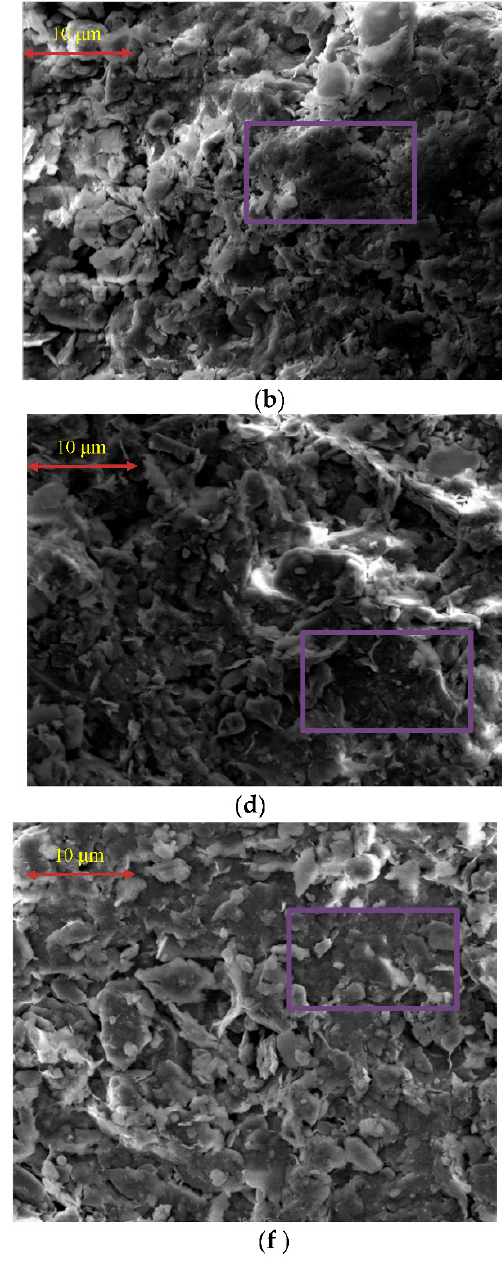
Figure 10. SEM images: ( a ) first-cycle frozen soil after cyclic loading at − 10 °C; ( b ) second-cycle frozen soil after cyclic loading at − 10 °C; ( c ) first-cycle frozen soil after cyclic loading at − 20 °C; ( d ) second-cycle frozen soil after cyclic loading at − 20 °C; ( e ) first-cycle frozen soil after cyclic loading at − 30 °C; ( f ) second-cycle frozen soil after cyclic loading at − 30 °C.